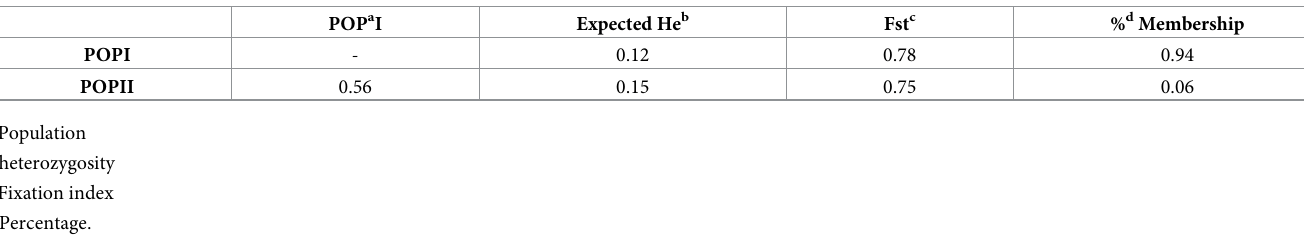
Table 2. Pairwise comparison (Fst) and expected heterozygosity among the two subpopulations using the model-based